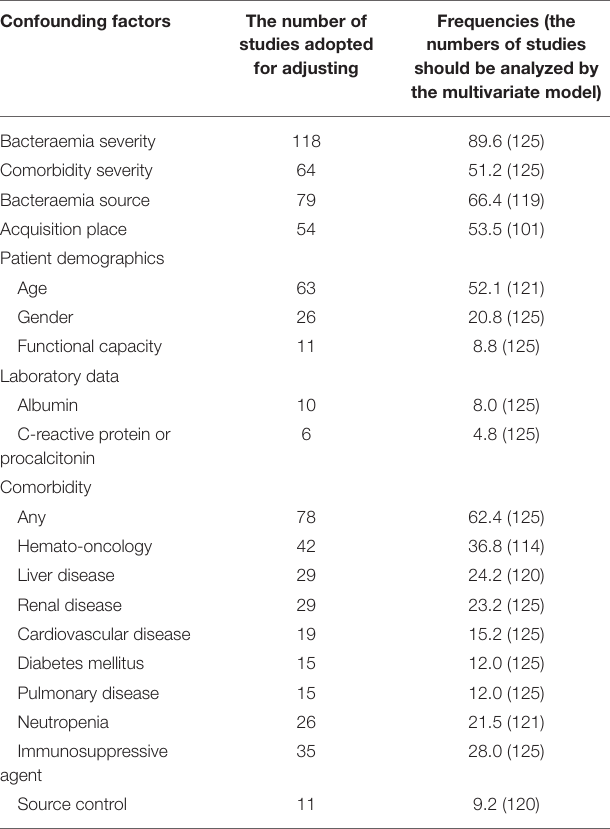
TABLE 3 | The distribution of confounding factors adjusted for multivariate analyses. Confounding